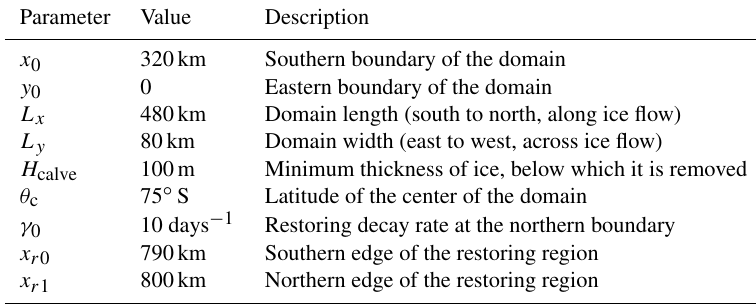
Table 3. Parameters shared between all five ISOMIP + experiments. Parameter Value Description x 0 320km Southern boundary of the domain Eastern boundary of the